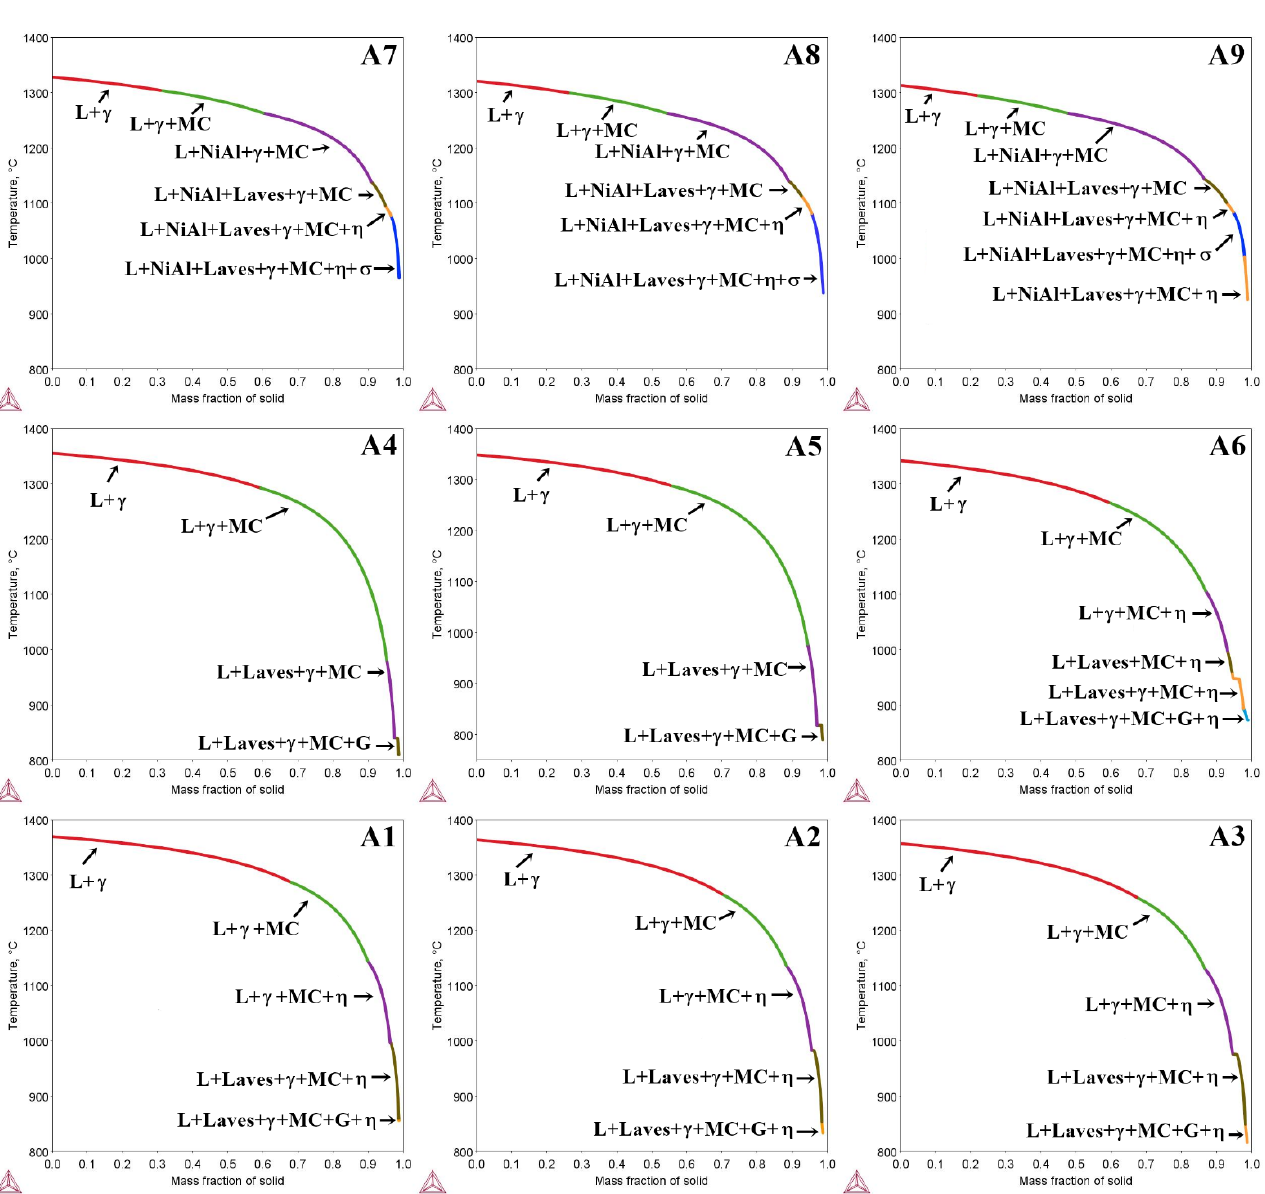
Figure 2. Scheil solidification simulation of the (A1 – A9) superalloys.